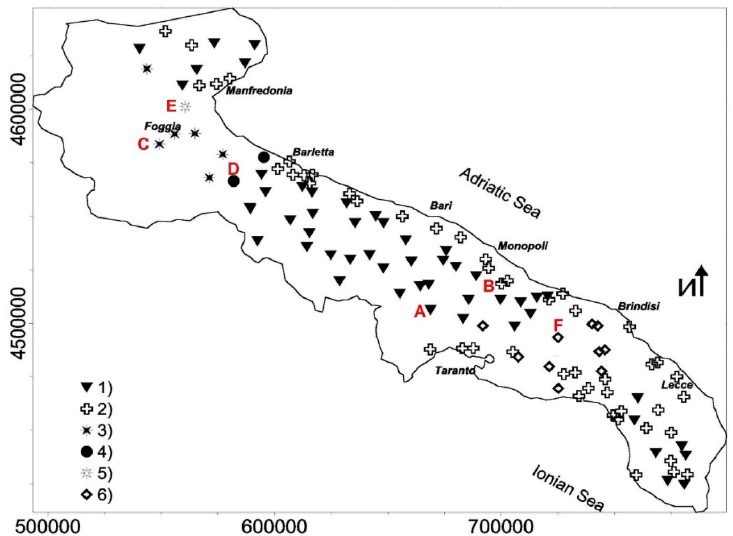
Figure 6. Monitoring wells and log types. Log type and selected examples of wells and logs (from A to F in Figures 6 and 7): (1) type A; (2) type B; (3) type C; (4) type D; (5) type E; (6) type